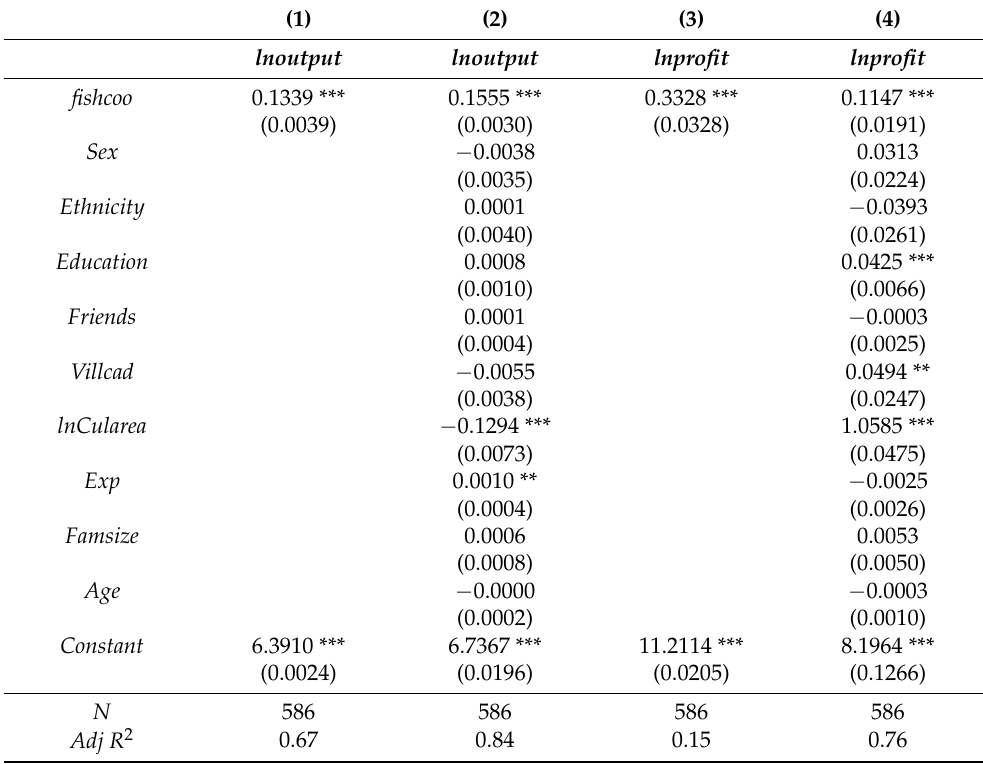
Table 2. Estimation results of cooperative participation